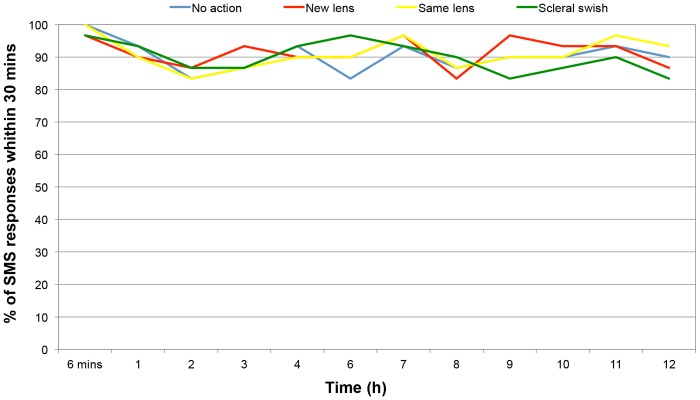
Percentage of SMS responses received within 30 minutes for all intervention groups.